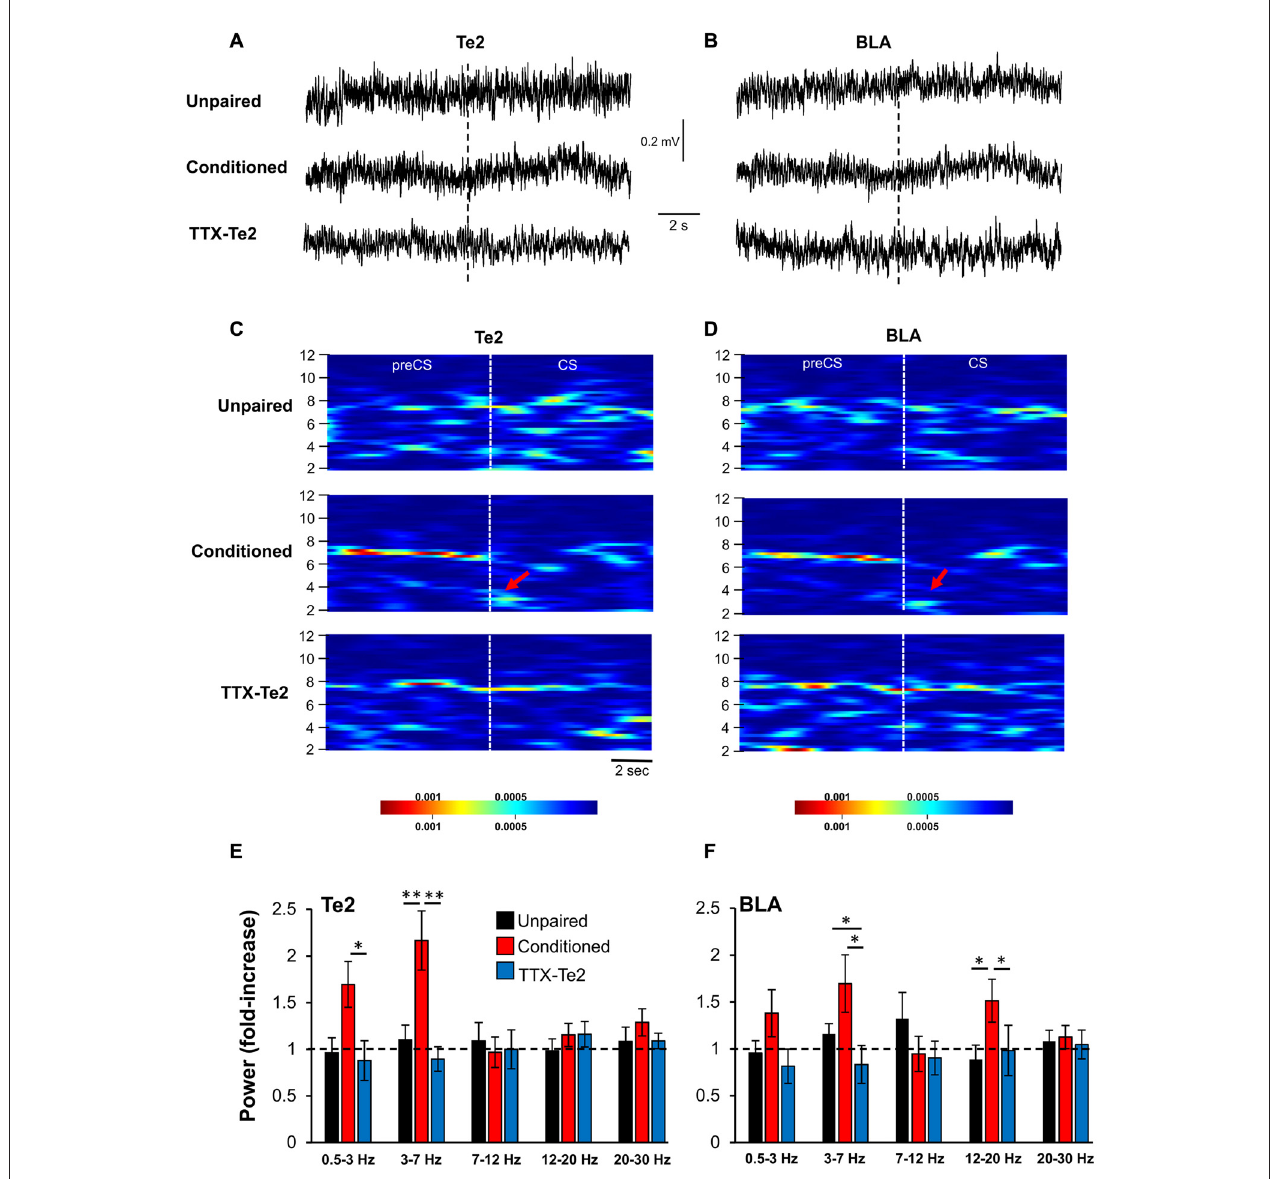
FIGURE 4 | The inactivation of the Te2 cortex abolished LFP activity in BLA during the presentation of the first overall CS. Representative LFP traces recorded in Te2 (A) and BLA (B) around the first CS (dotted line). Descriptive spectrograms of Te2 (C) and BLA (D) of the overall first CS (8 s) in unpaired ( n = 10), a conditioned ( n = 12) and a TTX-treated rats (TTX-Te2; n = 9). Red arrows indicate the increased activity in the low-theta range in the conditioned animal. Low-theta activity in the TTX-treated group did not change with respect to the unpaired group in both Te2 (E) and BLA (F) (sign-rank, P > 0.05), while conditioned rats displayed an increased low-theta activity in both areas with respect to unpaired and TTX-treated rats (sign-rank, P < 0.05). All data are expressed as mean ± SEM. ∗ P < 0.05; ∗∗ P <